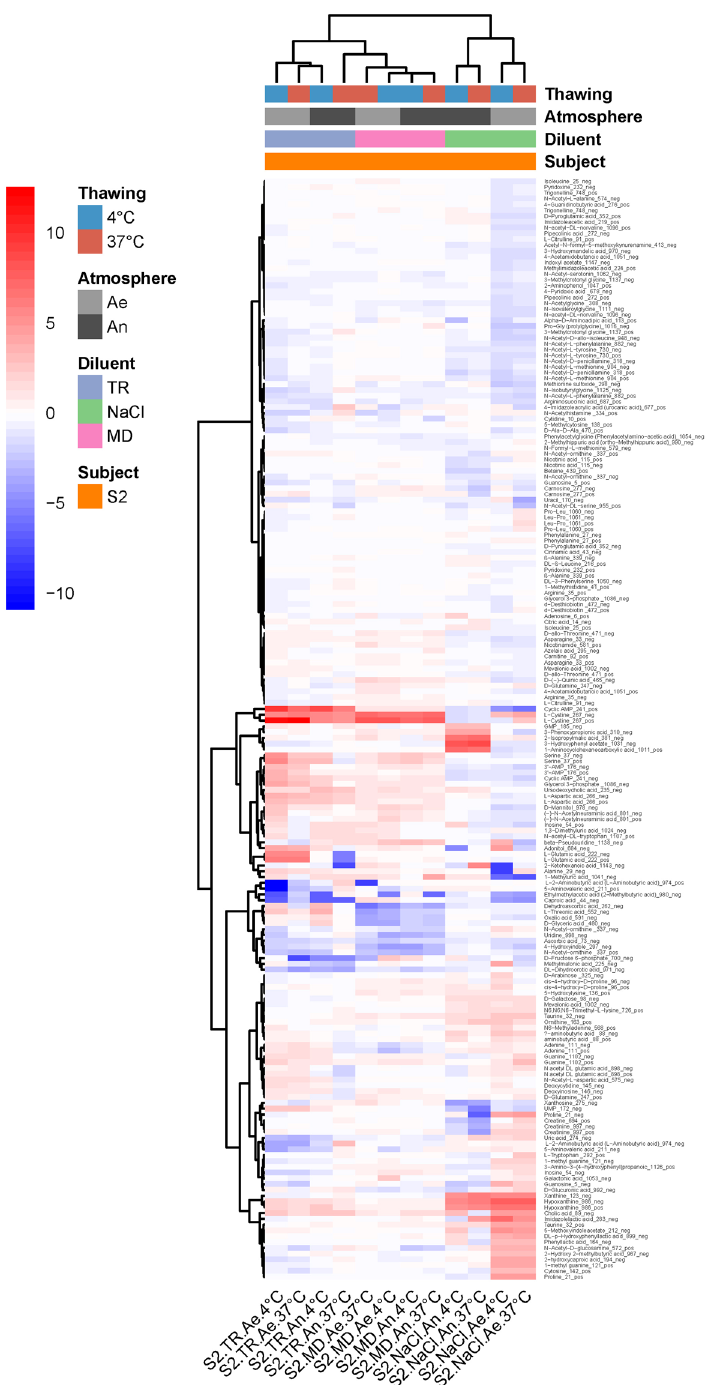
Figure 6. Heatmap of log2(condition/baseline) for metabolite abundance in cultures of fecal transplants (from S2, the same as on Fig. 5) that have been frozen at -80 °C for two weeks. Conditions are the same as on Fig. 5. Baseline is metabolite abundance in the transplants before